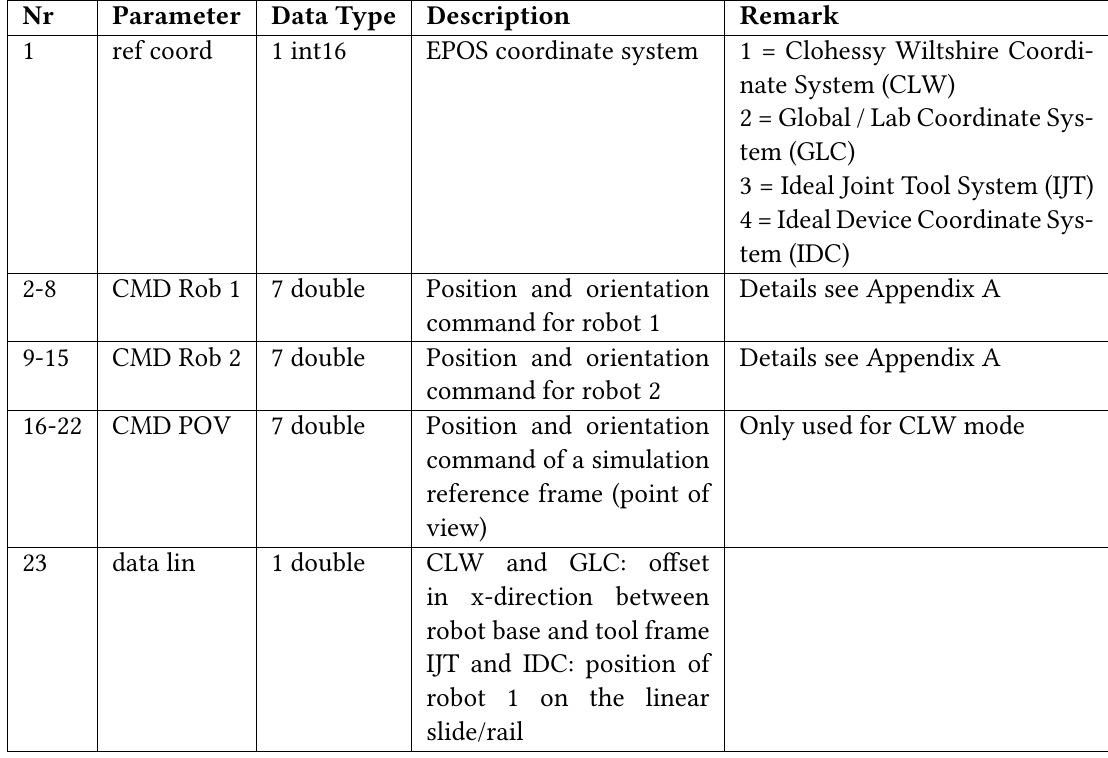
Table 4: Description of the parameters of a command line of an asynchronous command ASCII file